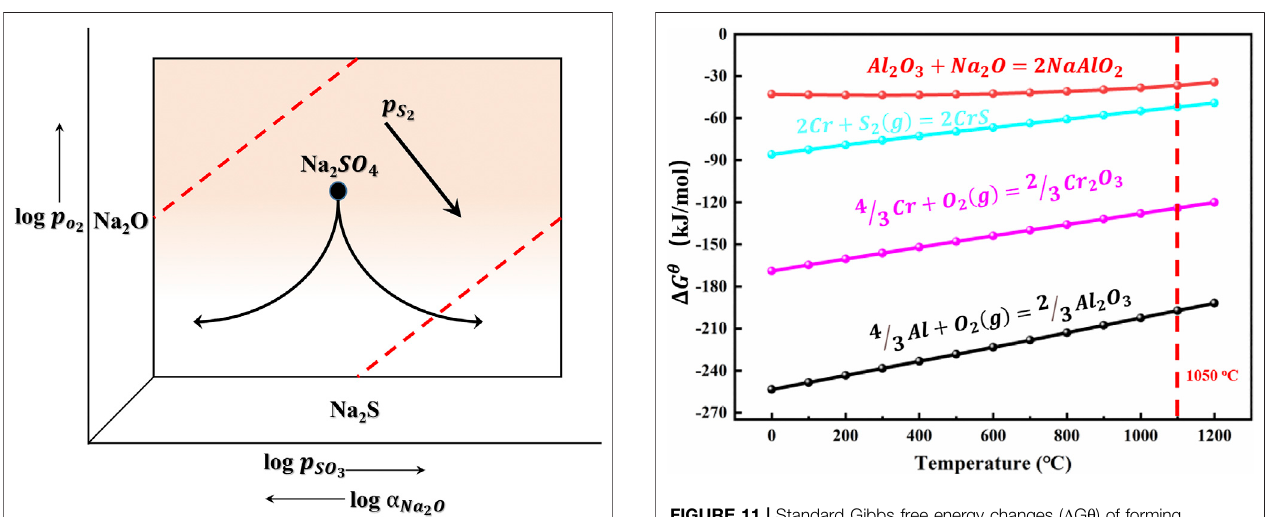
Frontiers in Materials |